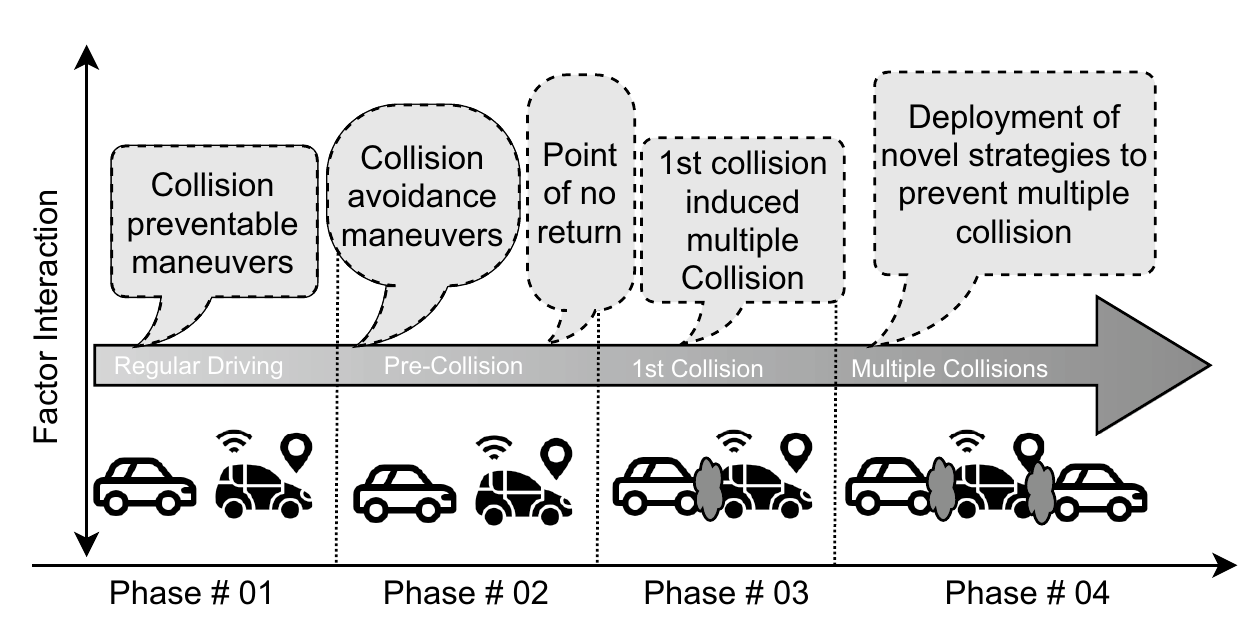
Figure 1. Multiple vehicle collisions illustration in four